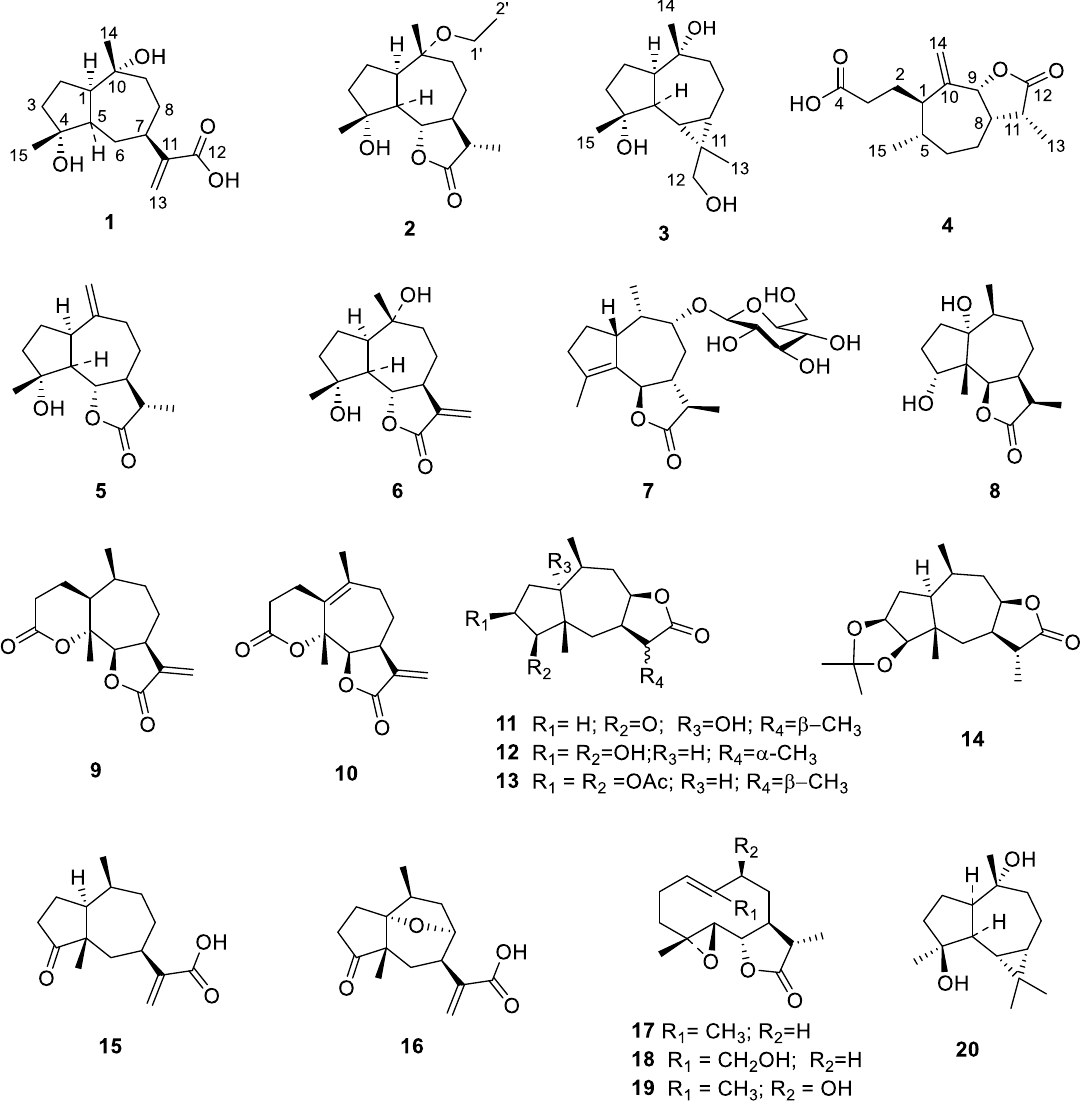
Figure 1. Structures of compounds 1 – 20 isolated from A. artemisiifolia .